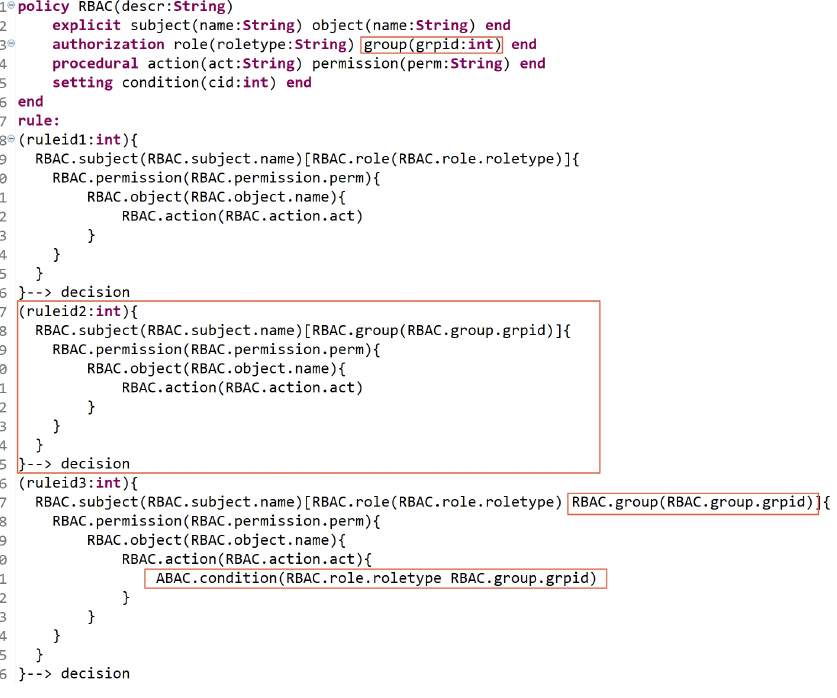
Figure 20. Extensibility: RBAC